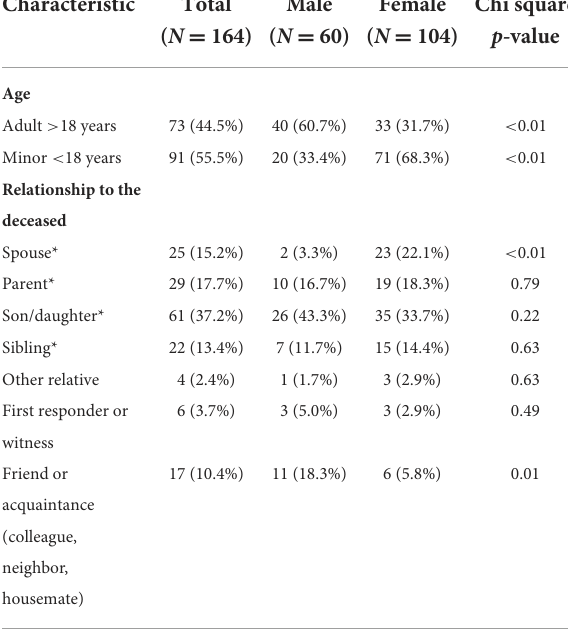
TABLE 3 Characteristics of individuals bereaved by a suspected suicide, 2019 to 2021.